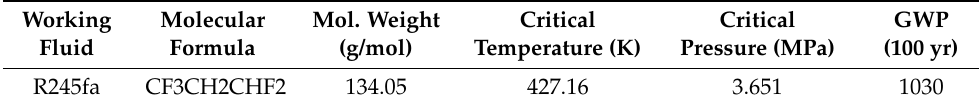
Figure 1. Schematic illustration of the ORC system. Table 1. Thermodynamic data of R245fa